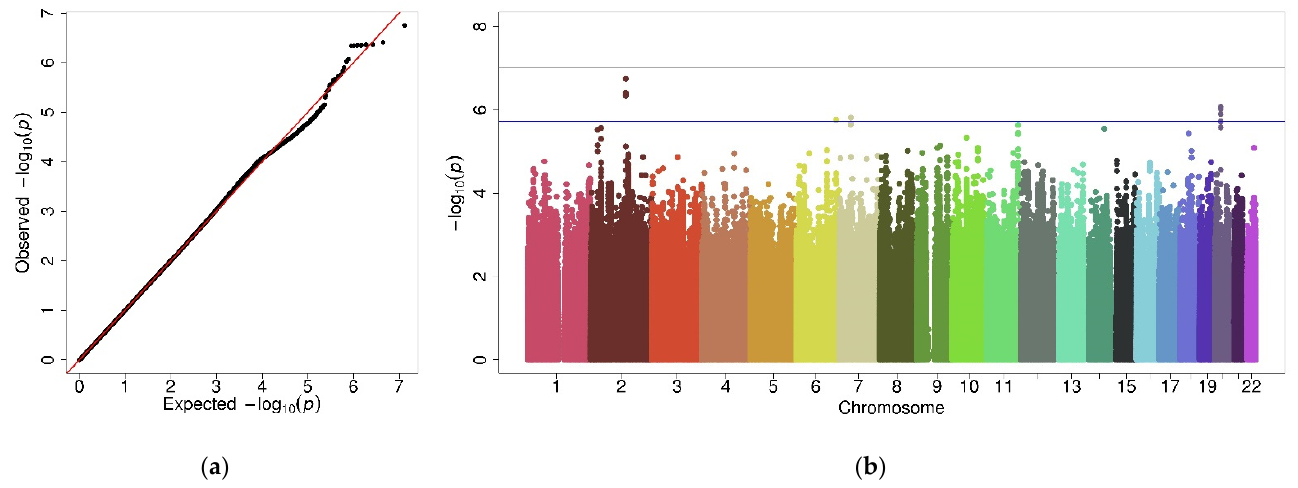
Figure 1. Graphic representation of the results from interaction GWAS. ( a ) Quantile-Quantile (Q-Q) plot showing the distribution of observed vs. expected p -values. ( b ) Manhattan plot showing the genetic variants association results. The X -axis shows the chromosomal position for each variant and the Y -axis shows a transformation of the association p -value ( − log 10 [ p -value]). The horizontal grey line shows the genome-wide significance threshold ( p = 9.4 × 10 − 8 ), and the blue line shows the suggestive significance threshold ( p = 1.9 × 10 − 6 ).